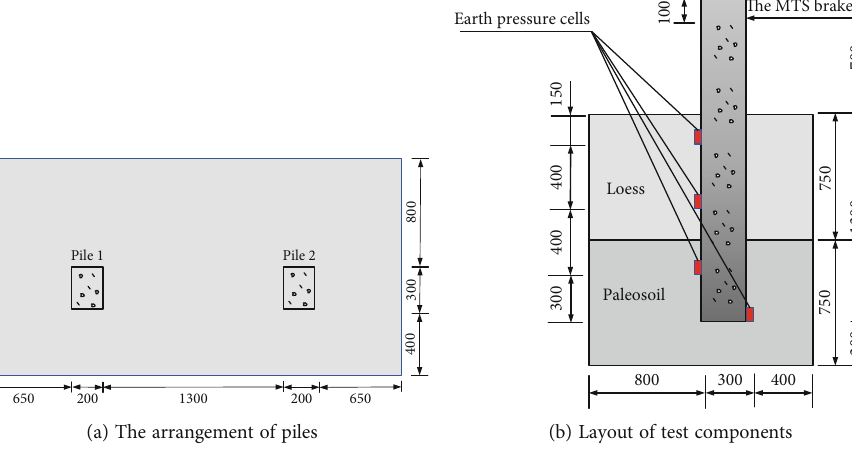
Figure 15: Model and test component layout (unit: mm).